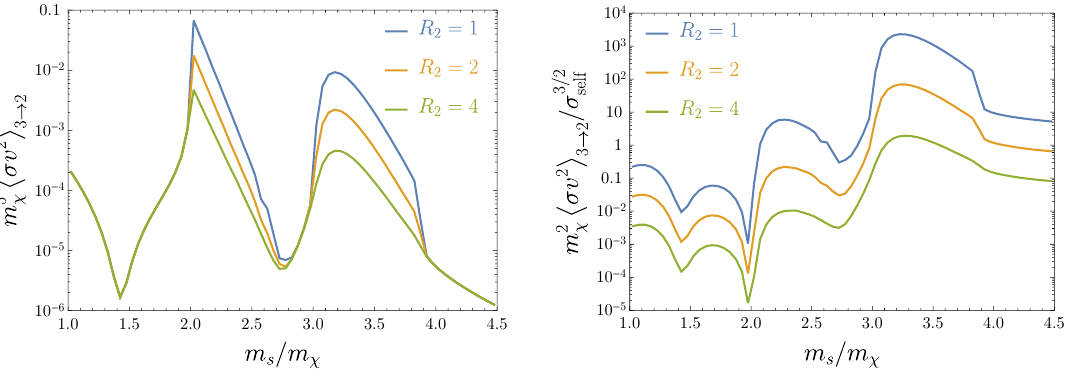
Figure 5 . The cross section h (cid:27) 3 ! 2 v 2 i (left) and the dimensionless ratio of number-changing and elastic self-scattering rates (right), as a function of m S =m (cid:31) . p m = 5 g w . The (cid:8) vev preserves a discrete Z V D